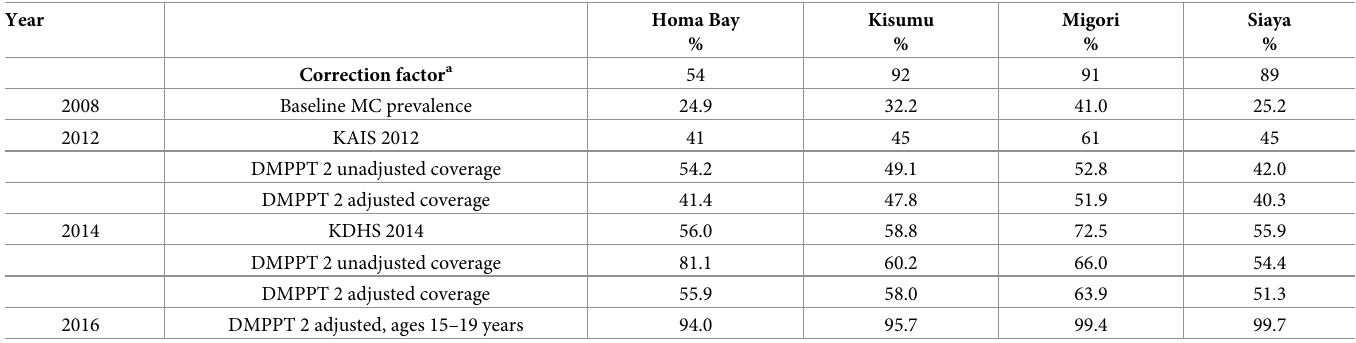
Table 1. Triangulation of coverage estimates and correction factors for Homa Bay, Kisumu, Migori, and Siaya.